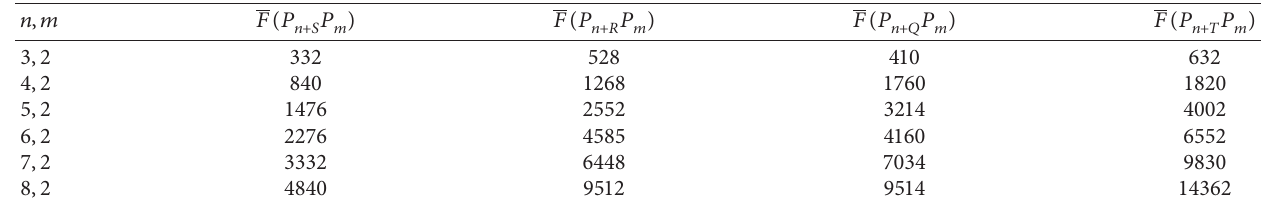
� P H � P n and m values of forgotten coindex for their 1 2